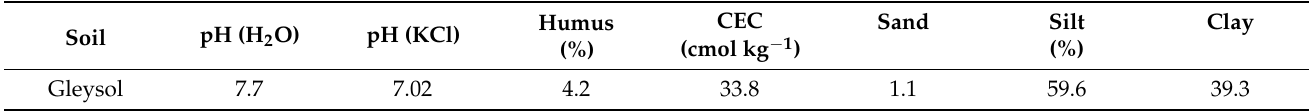
Table 1. Pedological properties of studied gleysol